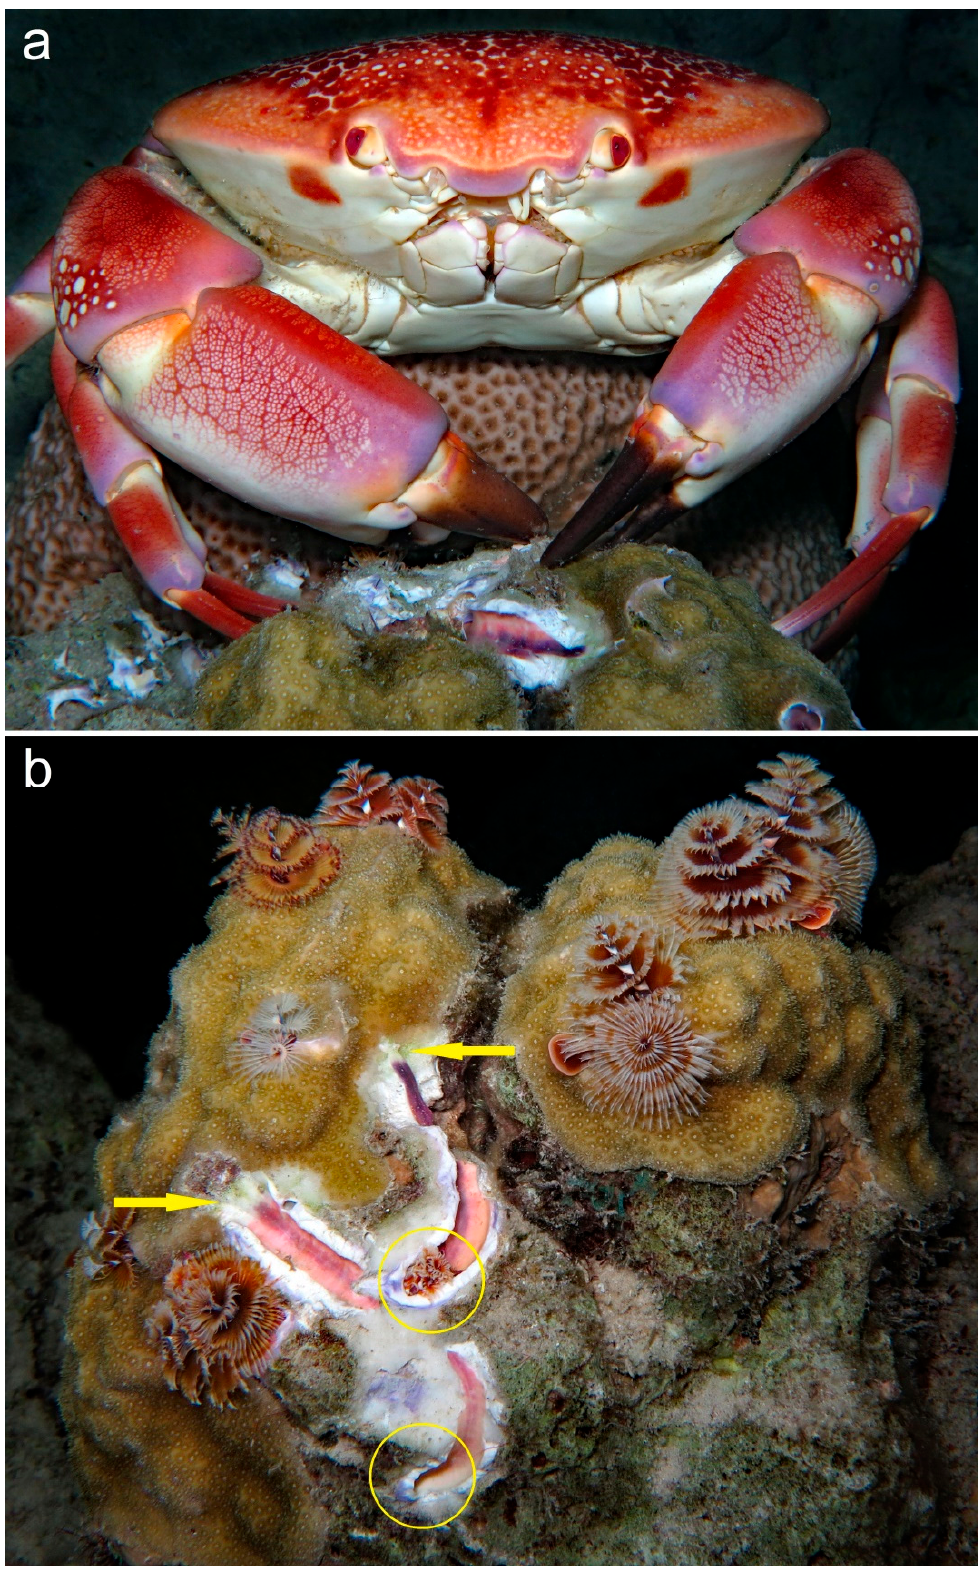
Figure 1. Predation of Christmas tree worms ( Spirobranchus giganteus ) in a coral of Porites astreoides by a Batwing coral crab ( Carpilius corallinus ) at Bonaire: ( a ) the crab foraging on worms; ( b ) two days later, two damaged worm tubes with one worm still alive. Arrows: position of worm tube openings. Circles: position of worm tubes exiting the coral skeleton. Photo credit: Ellen Muller.